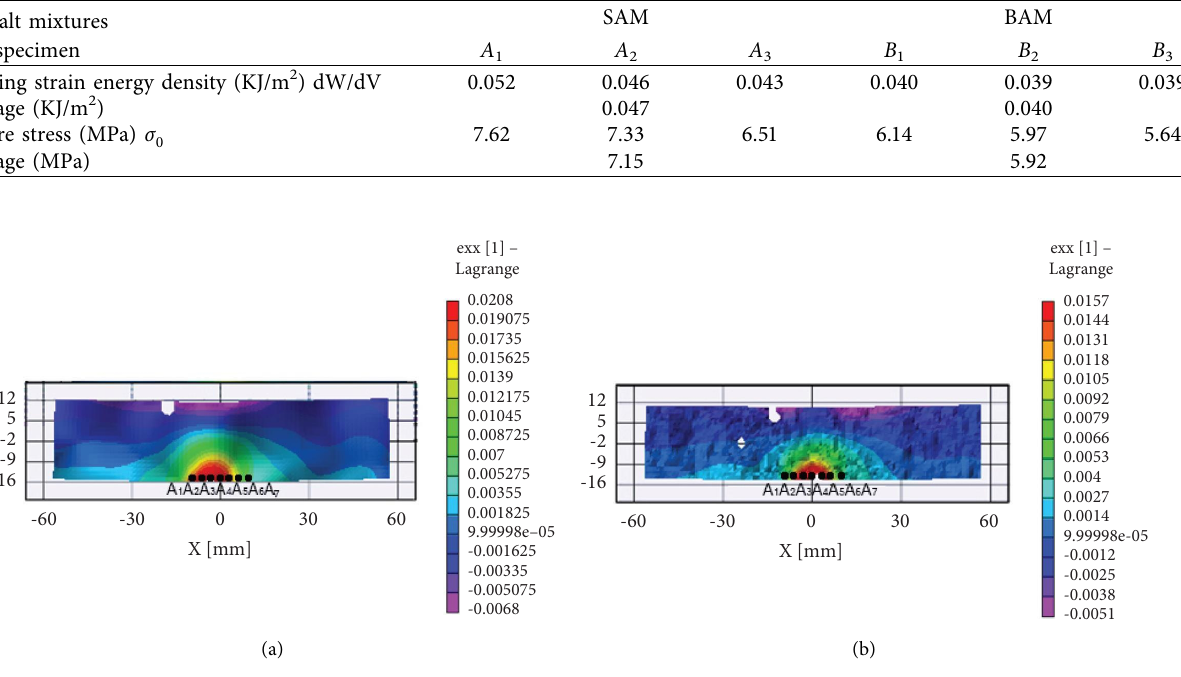
3 point from Figure 7;